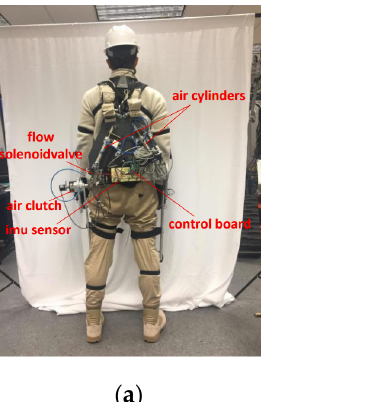
( b ) Figure 9. Brick laying robotic systems. ( a ) SAM 100 [140]. ( b ) Hadrian X [141]. 3.2.5. Universal Application Robot The development of the construction robotic system is not constrained to an automa- tion system but also extends to equip the construction worker with a robotic skeleton so